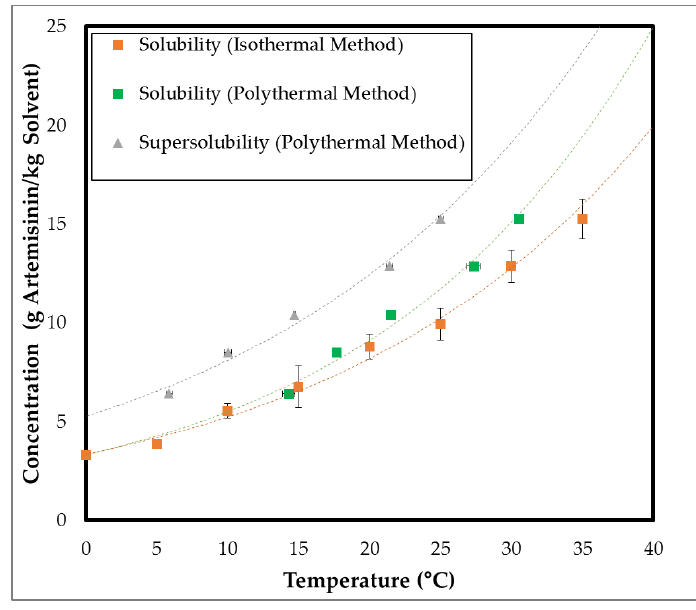
Figure 4. Metastable zone width of artemisinin in ethanol-water 60 wt.%.